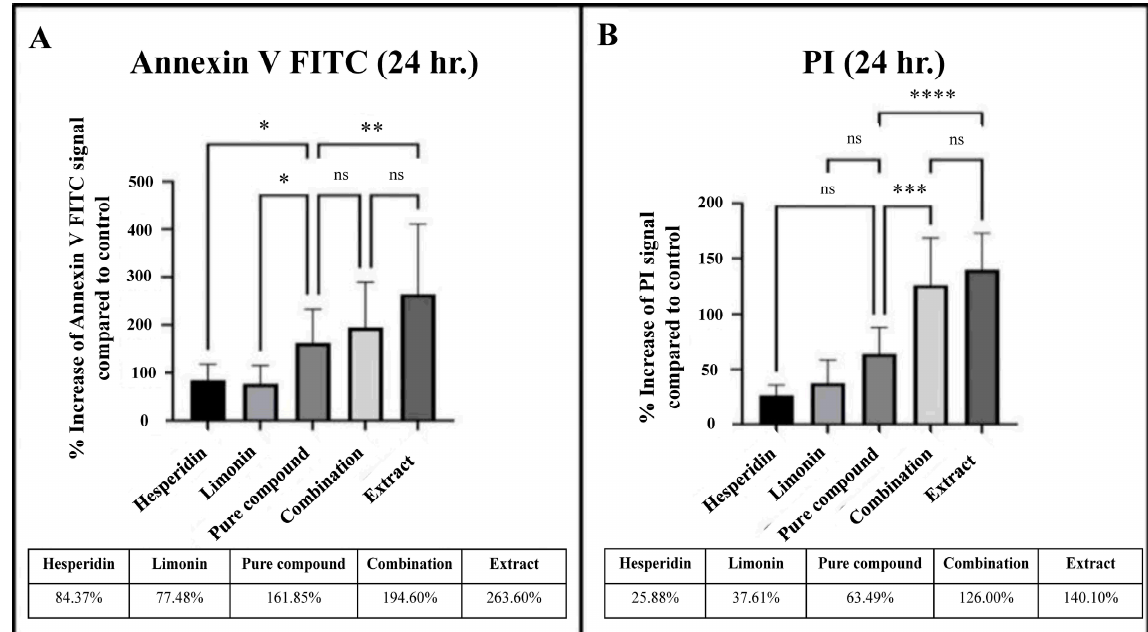
Figure 10. Percent increase of signal of Annexin V FITC ( A ) and PI ( B ) that stained in PLC/PRF/5 human hepatocellular carcinoma cells from flow cytometry analysis at 24 hr in each treatment. The statistical differences were analyzed by using one-way ANOVA followed by the Bonferroni com- parisons test. The symbol ns, *, **, *** and **** mean p > 0.05, < 0.05, <0.01, <0.001 and <0.0001, re- spectively.